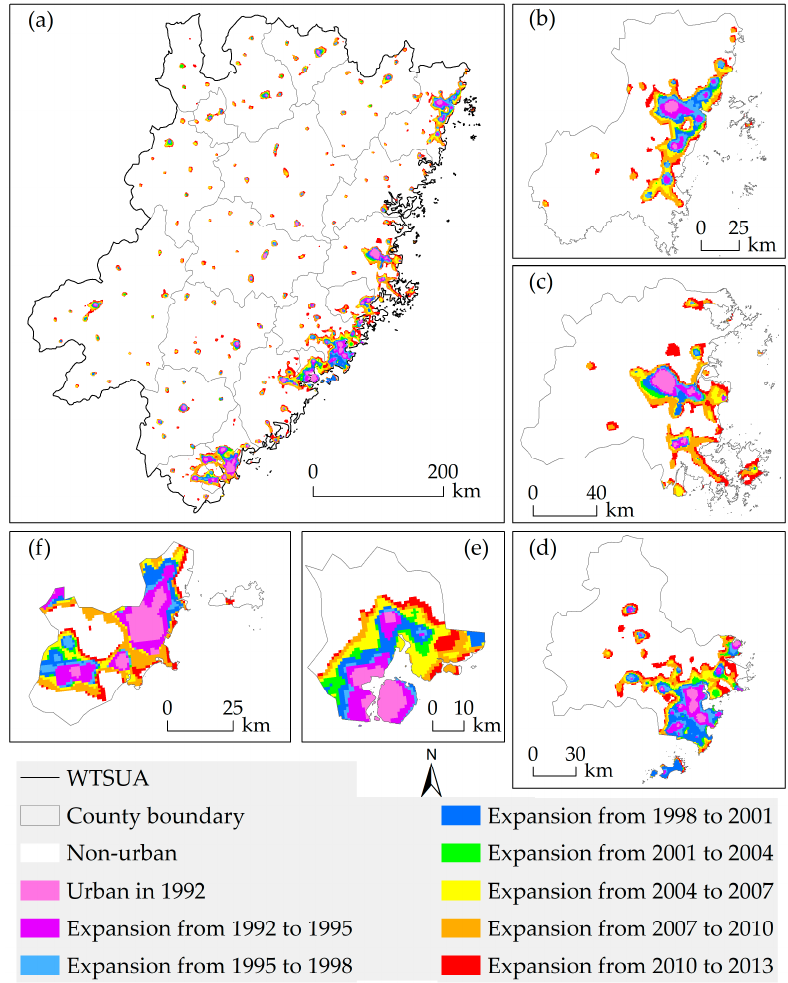
Figure 4. Spatio-temporal sprawl pattern of the WTSUA from 1992 to 2013. ( a ) spatio-temporal distribution of urban areas of the WTSUA from 1992 to 2013; ( b ) expansion dynamics of urban areas in Wenzhou city; ( c ) expansion dynamics of urban areas in Fuzhou city; ( d ) expansion dynamics of urban areas in Quanzhou city; ( e ) expansion dynamics of urban areas in Xiamen city; ( f ) expansion dynamics of urban areas in Shantou city.